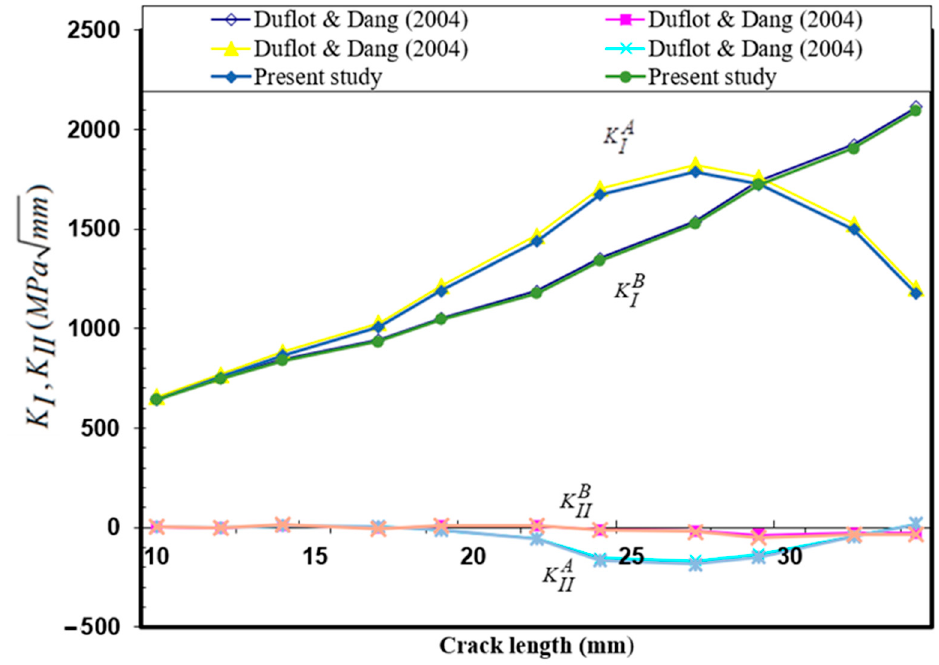
Figure 6. SIFs versus crack length comparison between the present study and the results of [5] for the two internal non-colinear crack specimens.